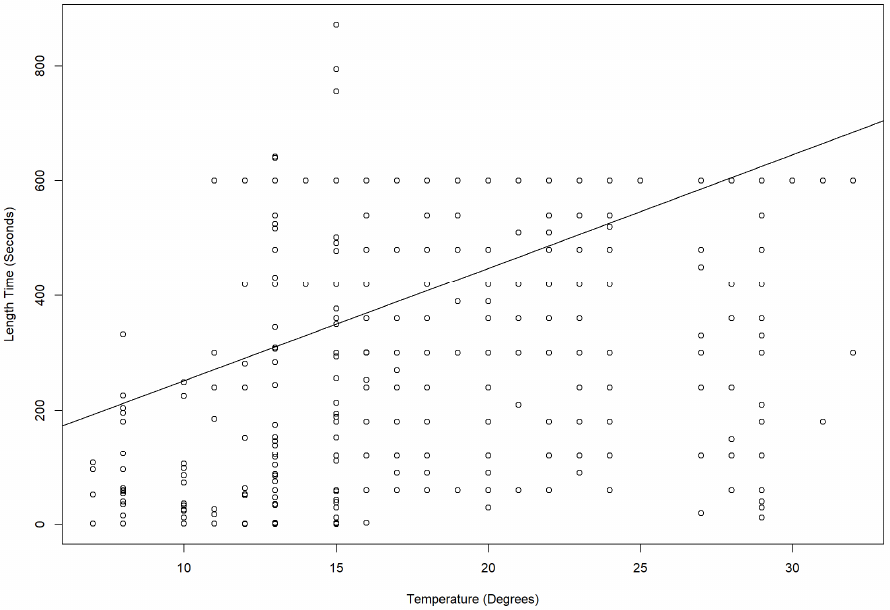
Figure 5. A linear model with a straight line fitted (R studio v 1.4.7) shows that the duration of sleeping events across all zoos was affected by